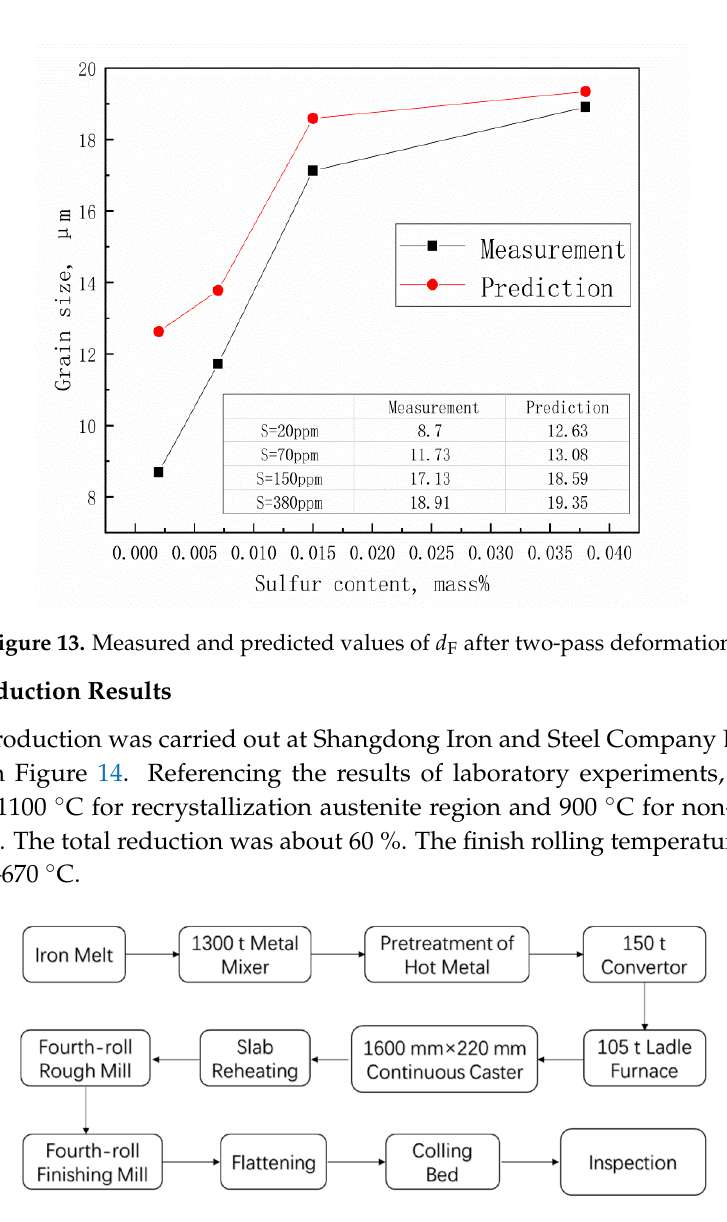
Figure 14. Process flow of DH36 structural steel in the industrial production.